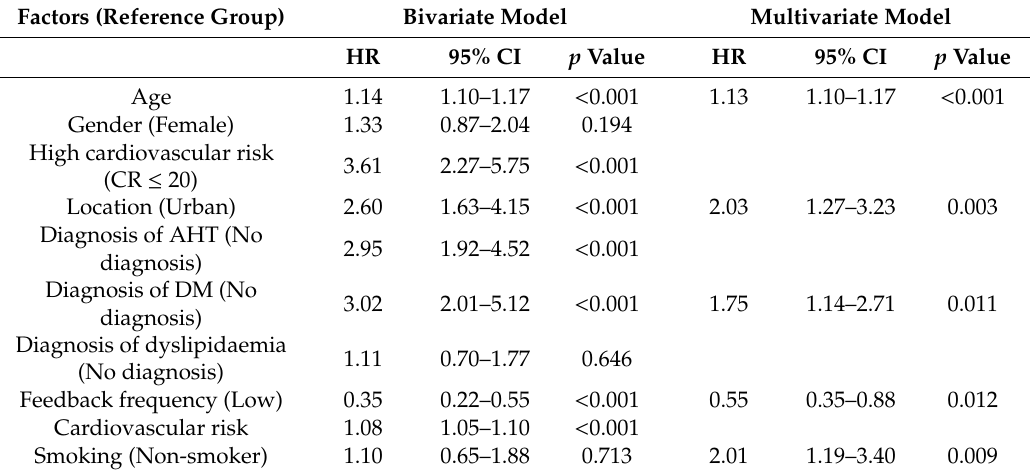
Table 5. Association between mortality and sociodemographic characteristics and indicators of health by multiple Cox